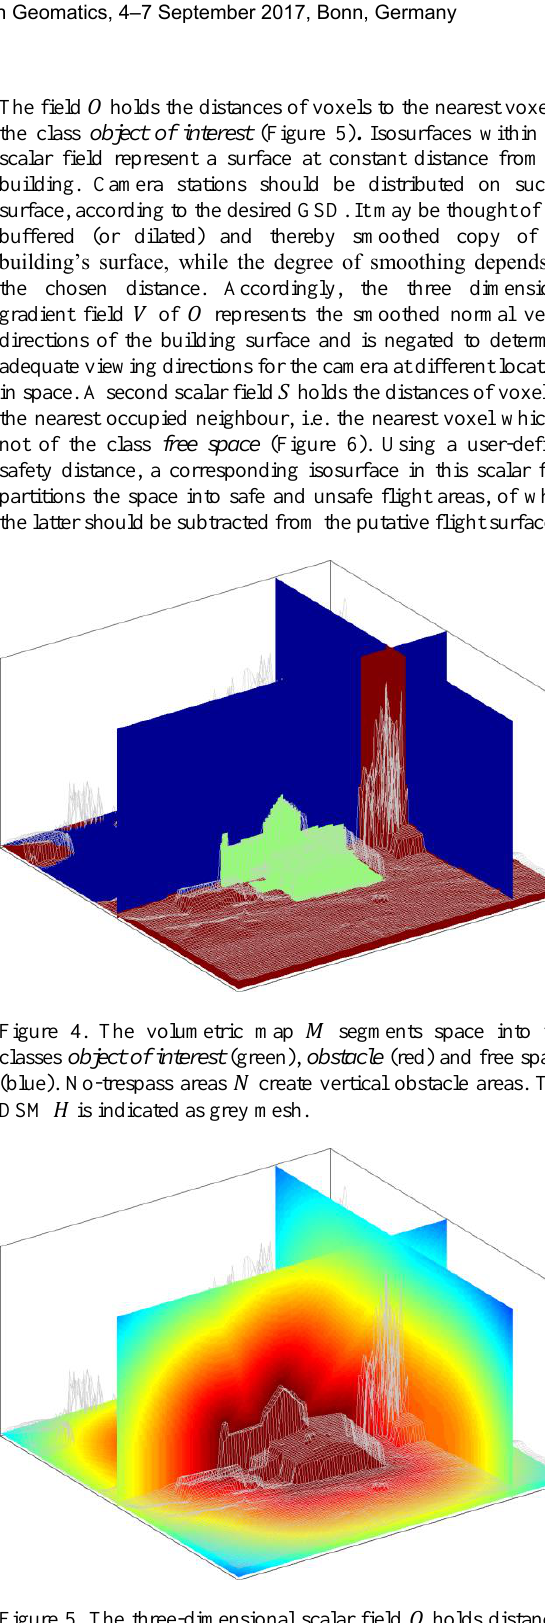
Figure 5. The three-dimensional scalar field 𝑂 holds distances to the object of interest (close to far, depicted as red to blue) . Its negated three-dimensional gradients are stored in the vector field 𝑉 and used as camera viewing